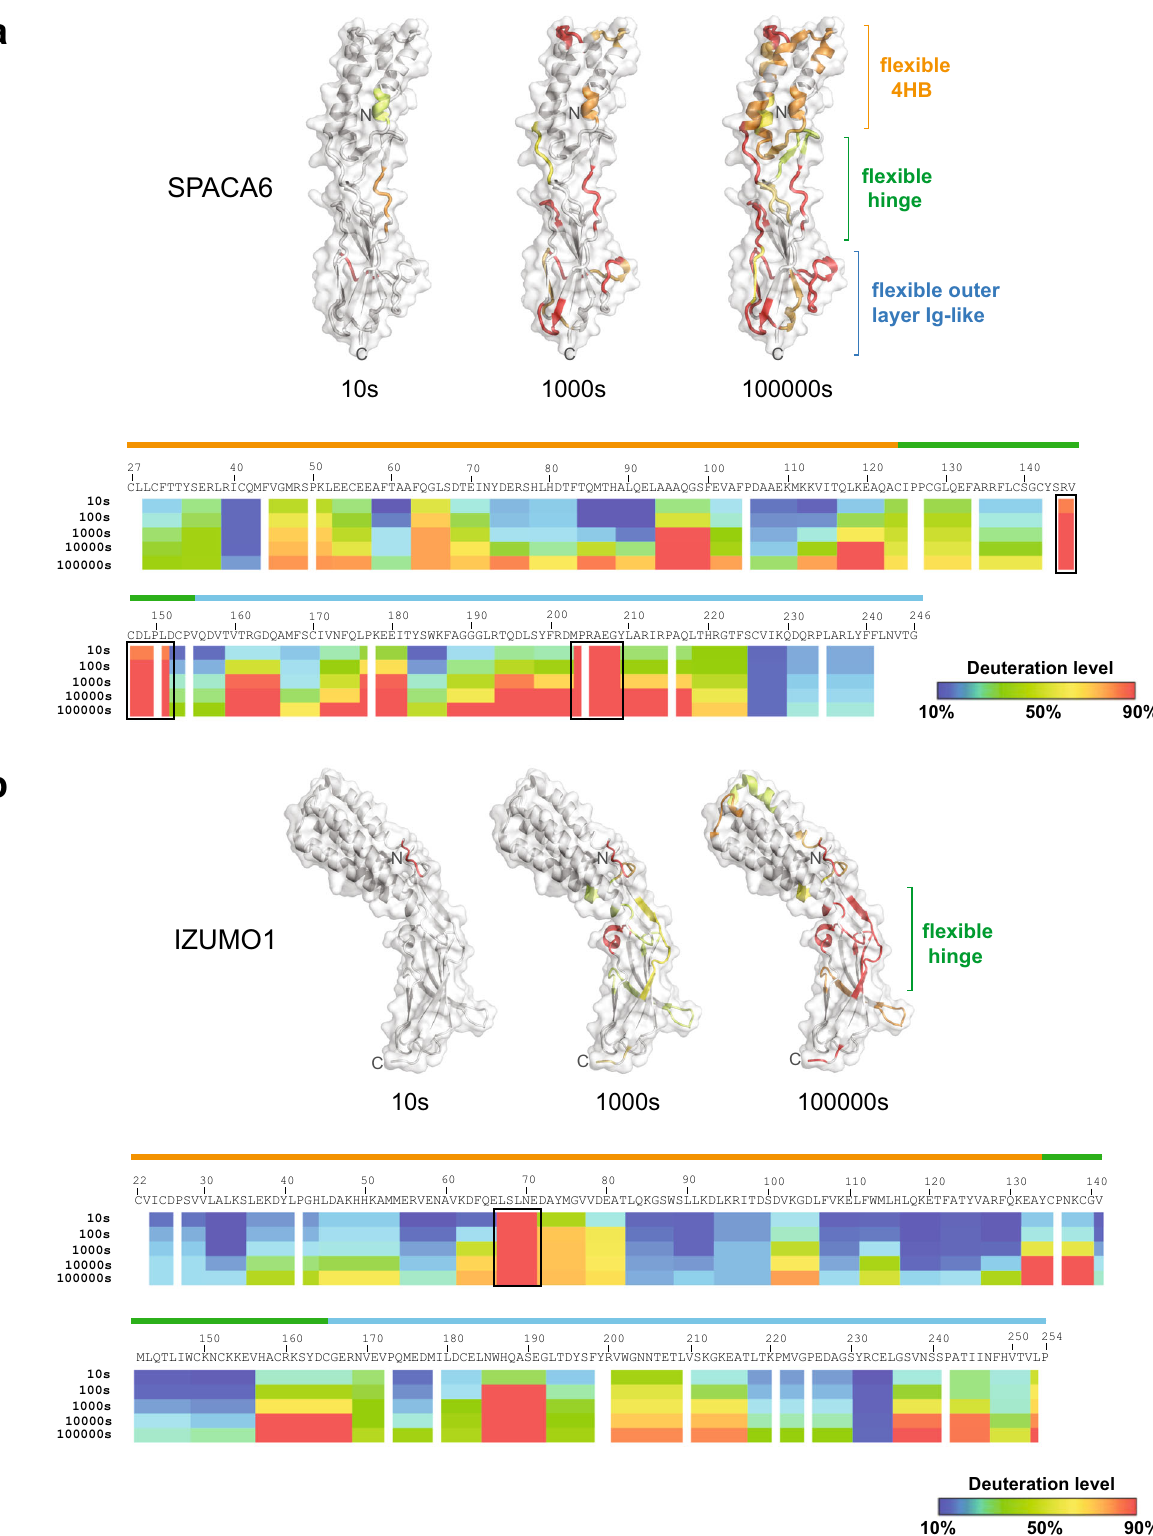
Fig. 7 Hydrogen-deuterium exchange mass spectrometry analysis of SPACA6. H-DXMS pro fi les of a SPACA6 and b IZUMO1. Percentage deuteration exchange was determined at indicated time points. Hydrogen-deuterium exchange levels are color coded in a gradient scale from blue (10%) to red (90%). Black boxes indicate areas of high exchange. The 4HB, hinge and Ig-like domain boundaries observed in the crystal structures are shown above the primary sequence. Deuterium exchange levels at 10 s, 1000 s, and 100,000 s are mapped onto a ribbon diagram overlayed with the transparent molecular surface of SPACA6 and IZUMO1. Portions of the structure with deuterium exchange levels below 50% are colored white. Areas above 50% H-DXMS exchange are colored on the gradient